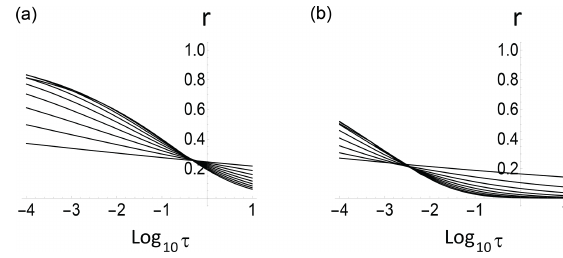
Figure 12. The ratio of ( α = 0) fRn skill to fGn skill ( a : 1-step horizon, b : 10-step forecast horizon) as a function of resolution τ for h increasing from (at left) bottom to top ( h = 1 / 20, 2 / 20, 3 / 20 ... 9 / 20); the h = 9 / 20 curve (close to the empirical value) is the curve that starts at the upper left of each plot.